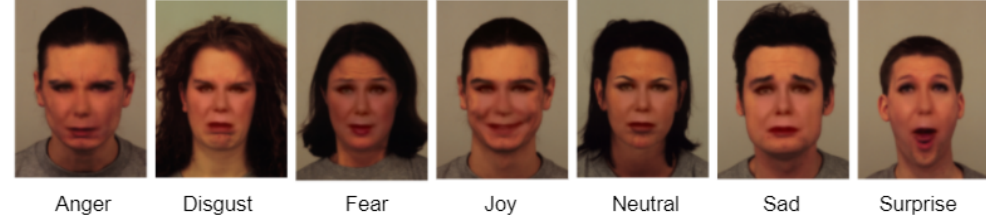
Figure 7. GAN generated images from KDEF database.